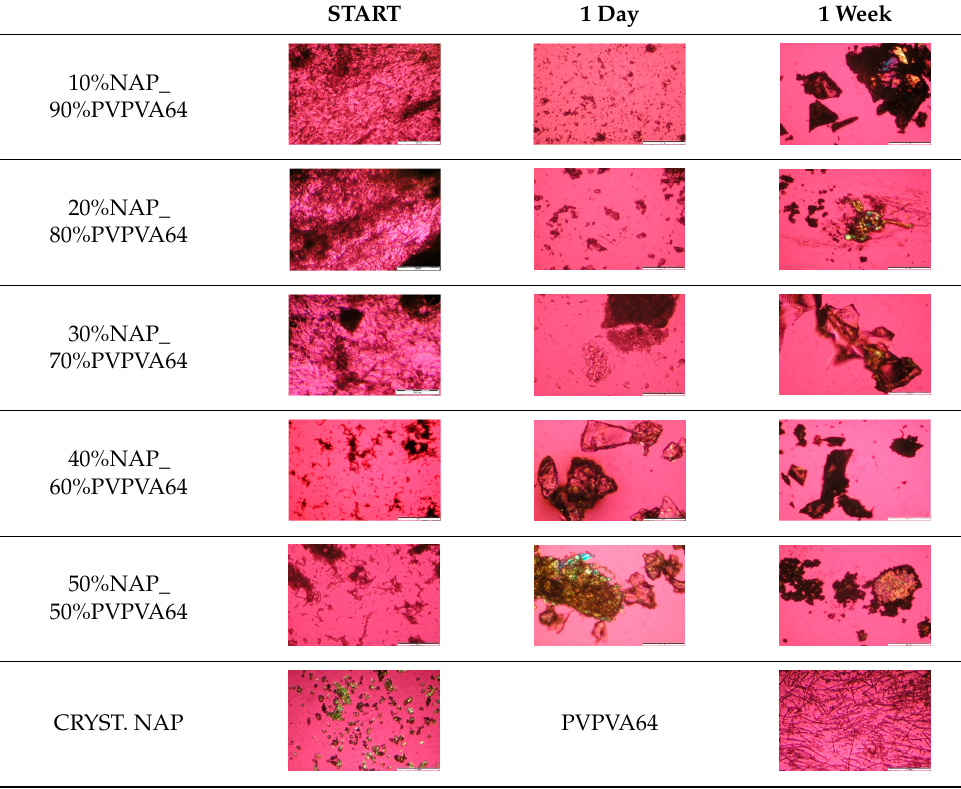
Table 4. PLM images of the samples before and after the stress stability test, and the images of the reference materials. START